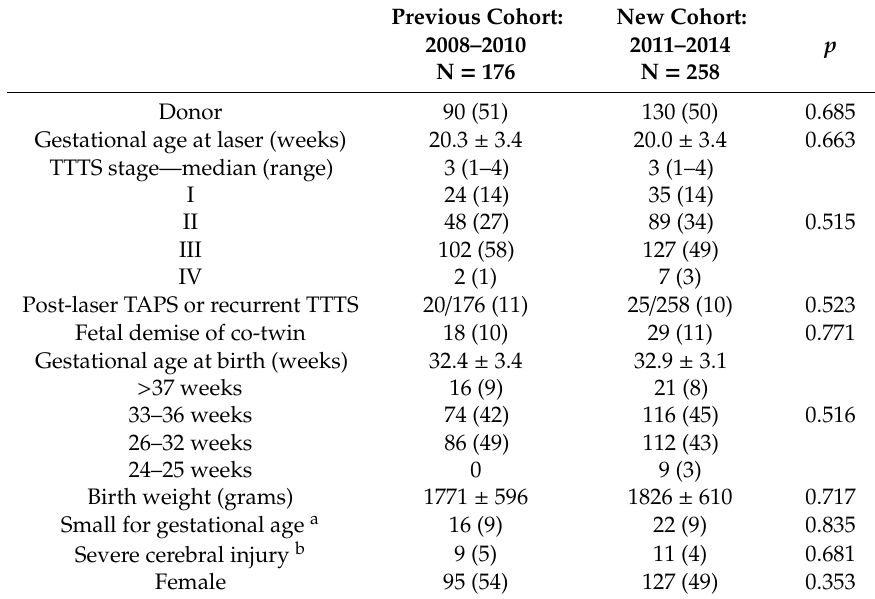
Table 1. Baseline characteristics of long-term TTTS survivors included for follow-up.